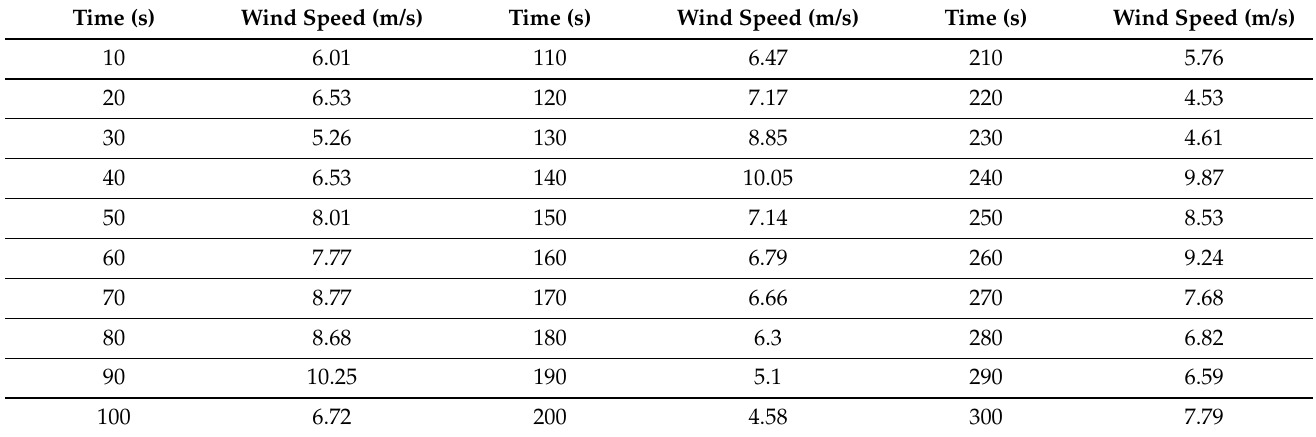
Table 7. Real wind speed values used for testing controller mathematical model performance.